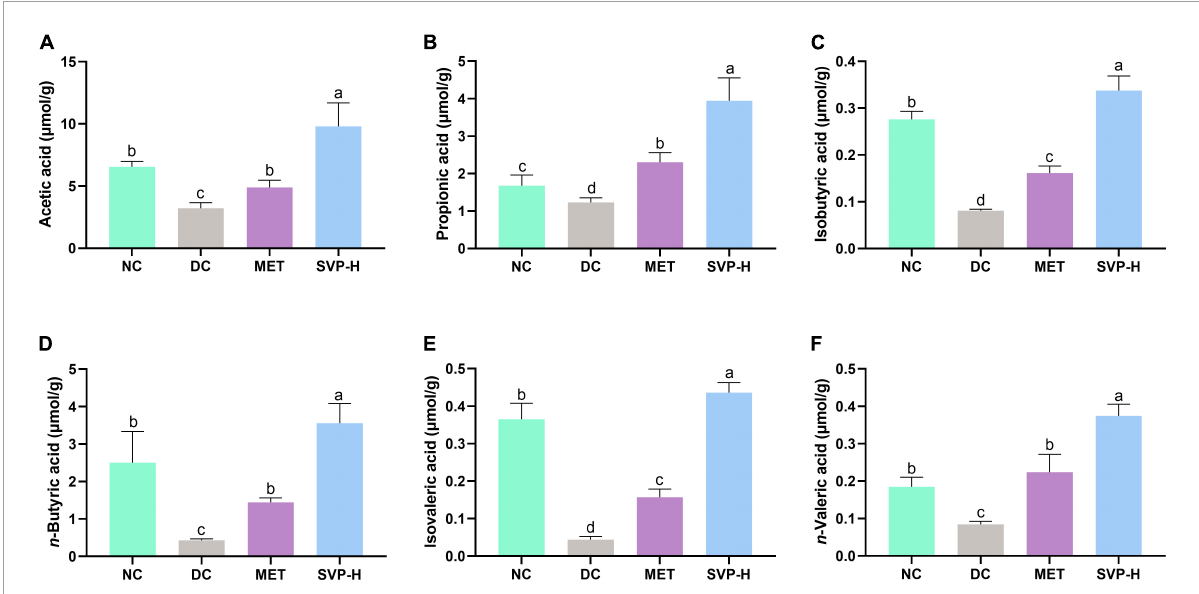
FIGURE5 Effects of oral SVP on the levels of fecal short-chain fatty acids (SCFAs). (A) Acetic acid; (B) propionic acid; (C) isobutyric acid; (D) n -butyric; (E) isovaleric acid; (F) n -valeric acid. Different superscript letters indicate statistically significant differences between the groups ( p <